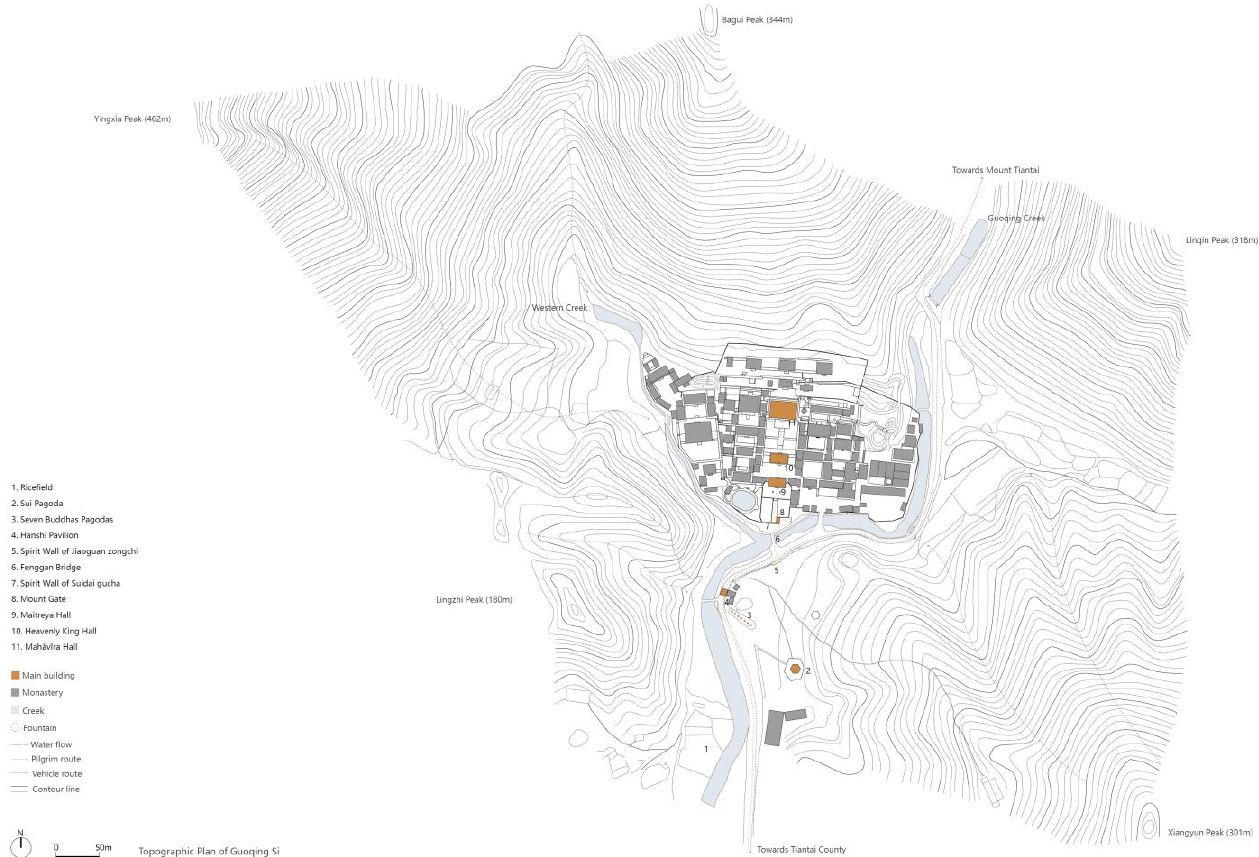
Figure 20. Topographic plan of Guoqing Si.